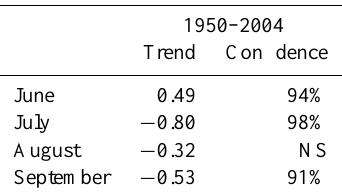
Table 1. Trend values and their significance of monsoon rainfall over India calculated from the All-India monsoon rainfall data from IITM for June, July, August and September for the period 1950–